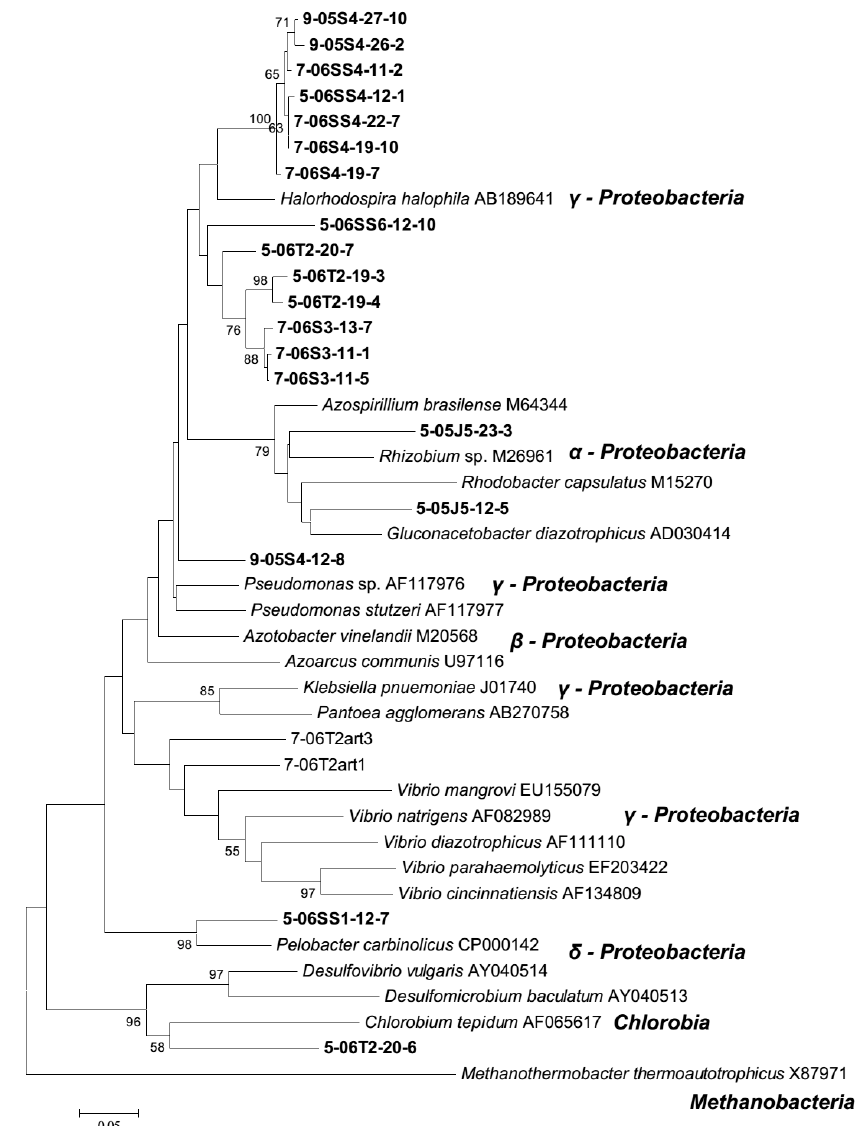
Figure 5. Phylogram of sequences from DGGE band stabs from 2005 and 2006 post drought rhizosphere samples (Nucleotide sequences, Neighbor-Joining, Jukes-Cantor correction, 1000 bootstrap replicates, complete deletion of gaps and missing data). Sequence names depict sampling date (prefix, e.g., 5-05 for month and year), plant zone (e.g., JS for Juncus roemerianus stand). Numbers following the prefix in the sequence name are ultimate band number and clone designation. Sequences from corresponding UBNs listed in diazotroph assemblage group 1 (Table S2) are